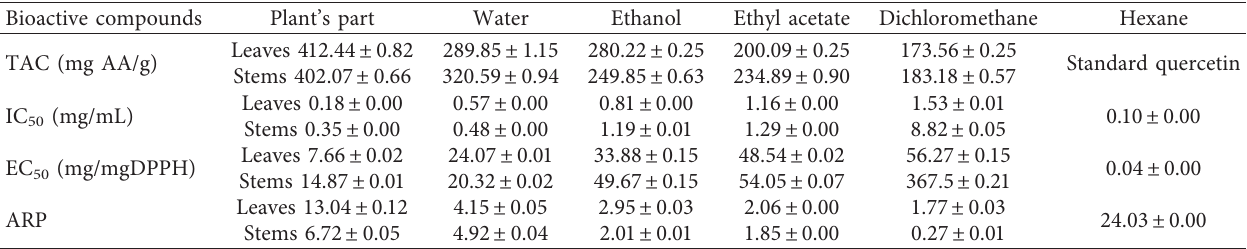
Table 6: Total antioxidant capacity (TAC), inhibitory concentration ( IC the extracts from Halimium halimifolium’s leaves and stems.